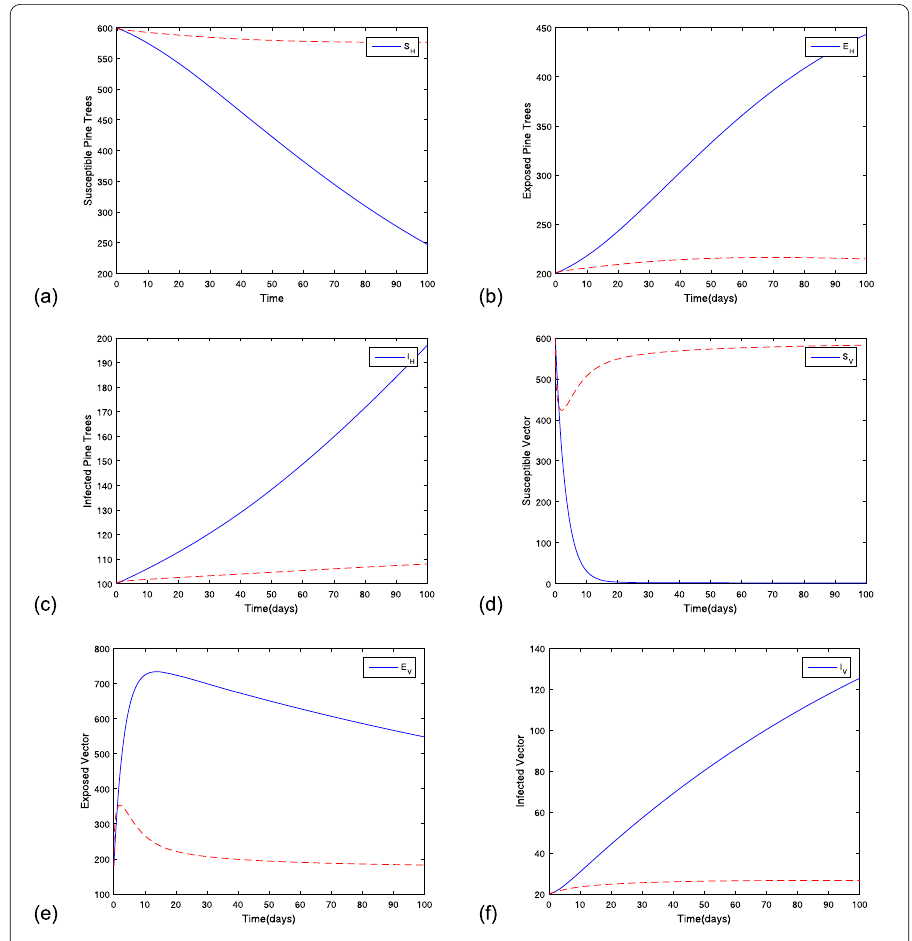
Figure 4 Simulations of pine tree population ( a )–( c ) and vector population ( d )–( f ) of the FPWD model (9) for τ = 0.4. ( a ): Susceptible pine tree; ( b ): Exposed pine tree; ( c ): Infected pine tree; ( d ): Susceptible vector; ( e ): Exposed vector; ( f ): Infected